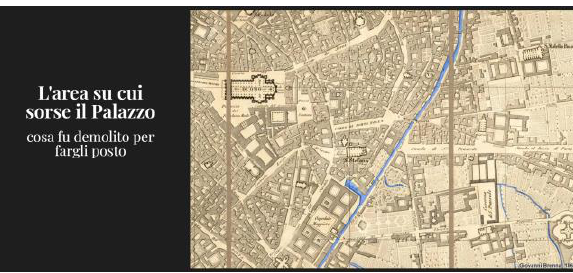
Fig. 21. Description of the area in which the palace was built.